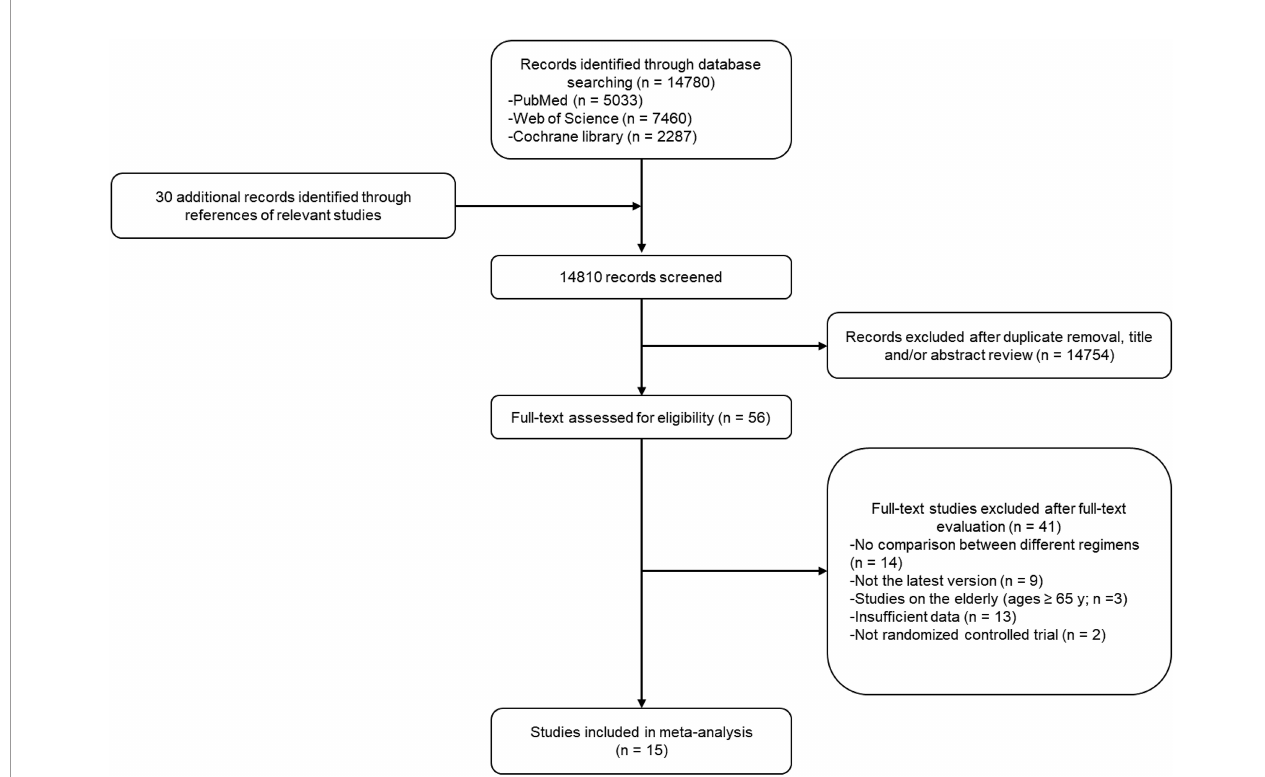
FIGURE 1 | Flowchart of the selection process of studies to be